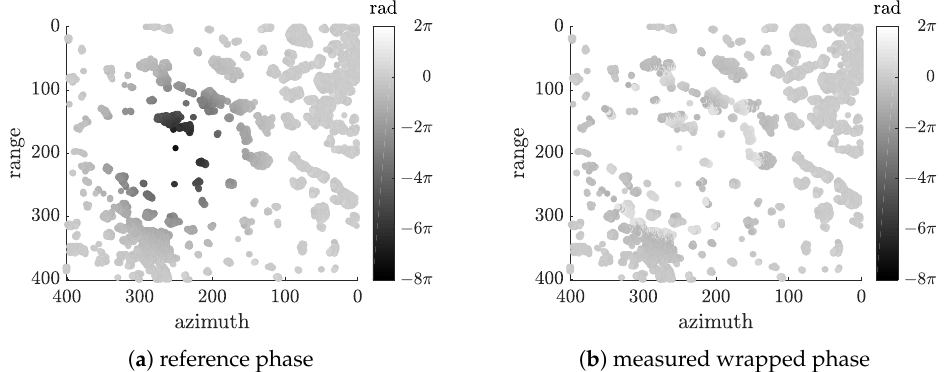
Figure 6. Coherent pixels of simulated ground settlement depression for one interferogram with a temporal baseline of ∆ t αβ =315days and an orthogonal spatial baseline of ∆ b ⊥ , αβ = −